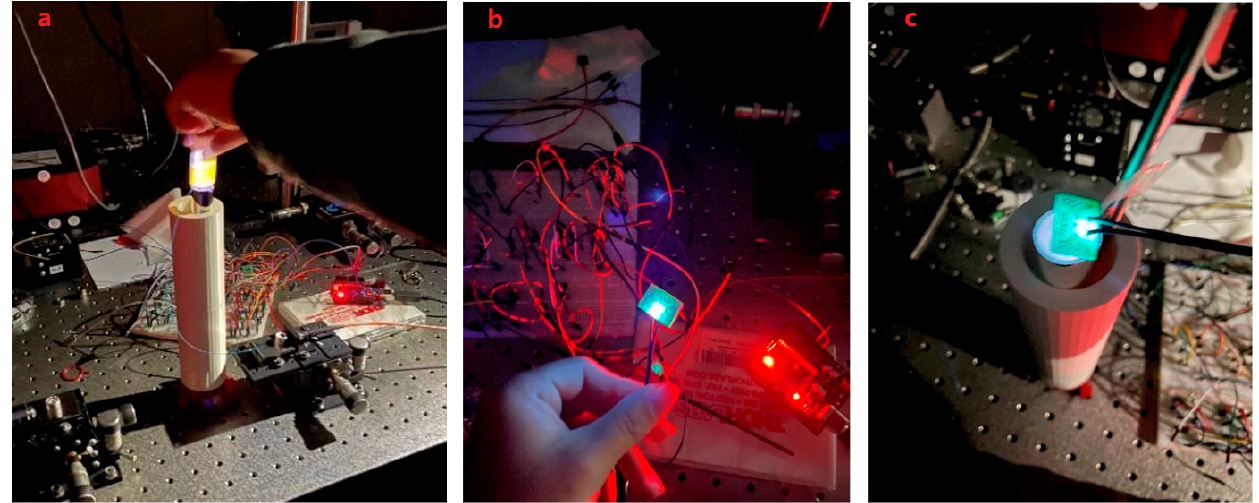
Figure 10. The yellow-light fluorescence of the Rhodamine B reagent under ultraviolet light ( a ), the designed LED ( b ), putting the UV-LED on top of the container in dark environment ( c